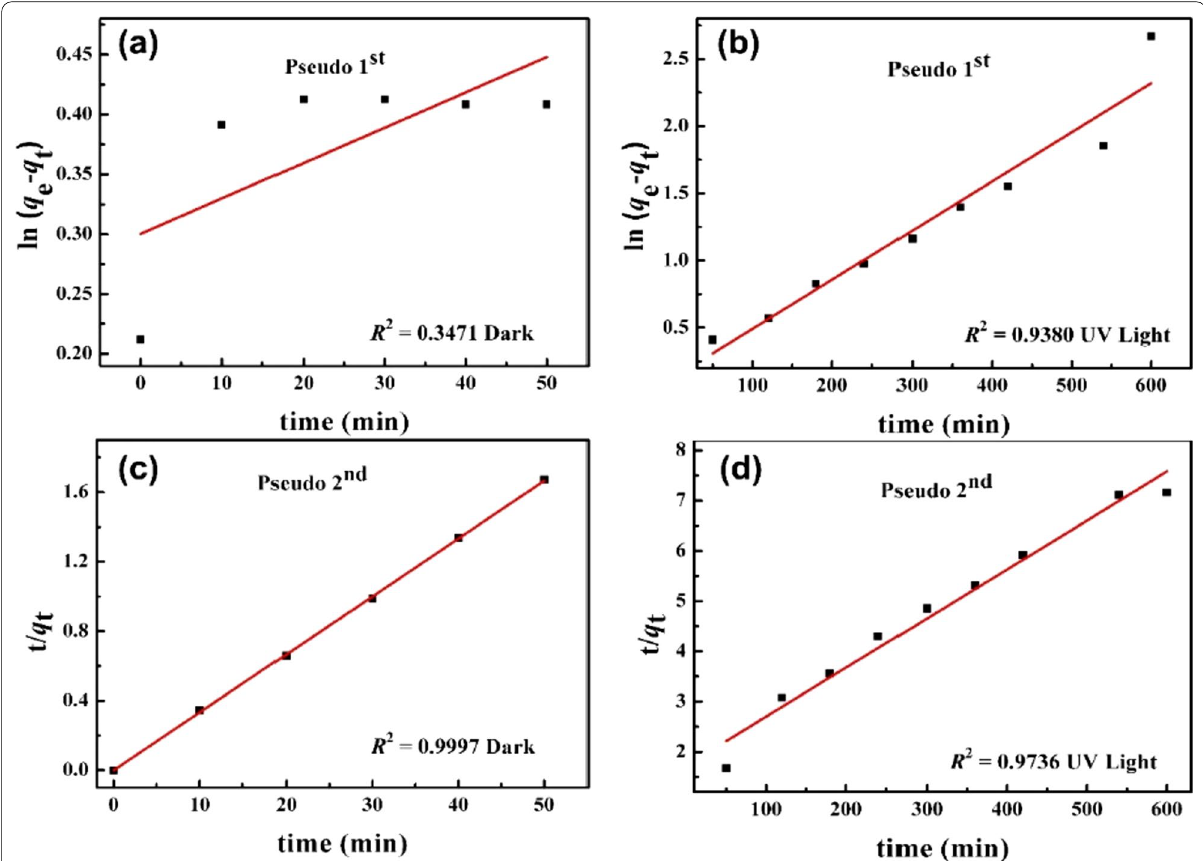
Fig. 9 The kinetic plots for removing BM by AgZnO/POMs nanocomposites, a and b pseudo-first-order kinetics, c and d pseudo-second-order kinetics